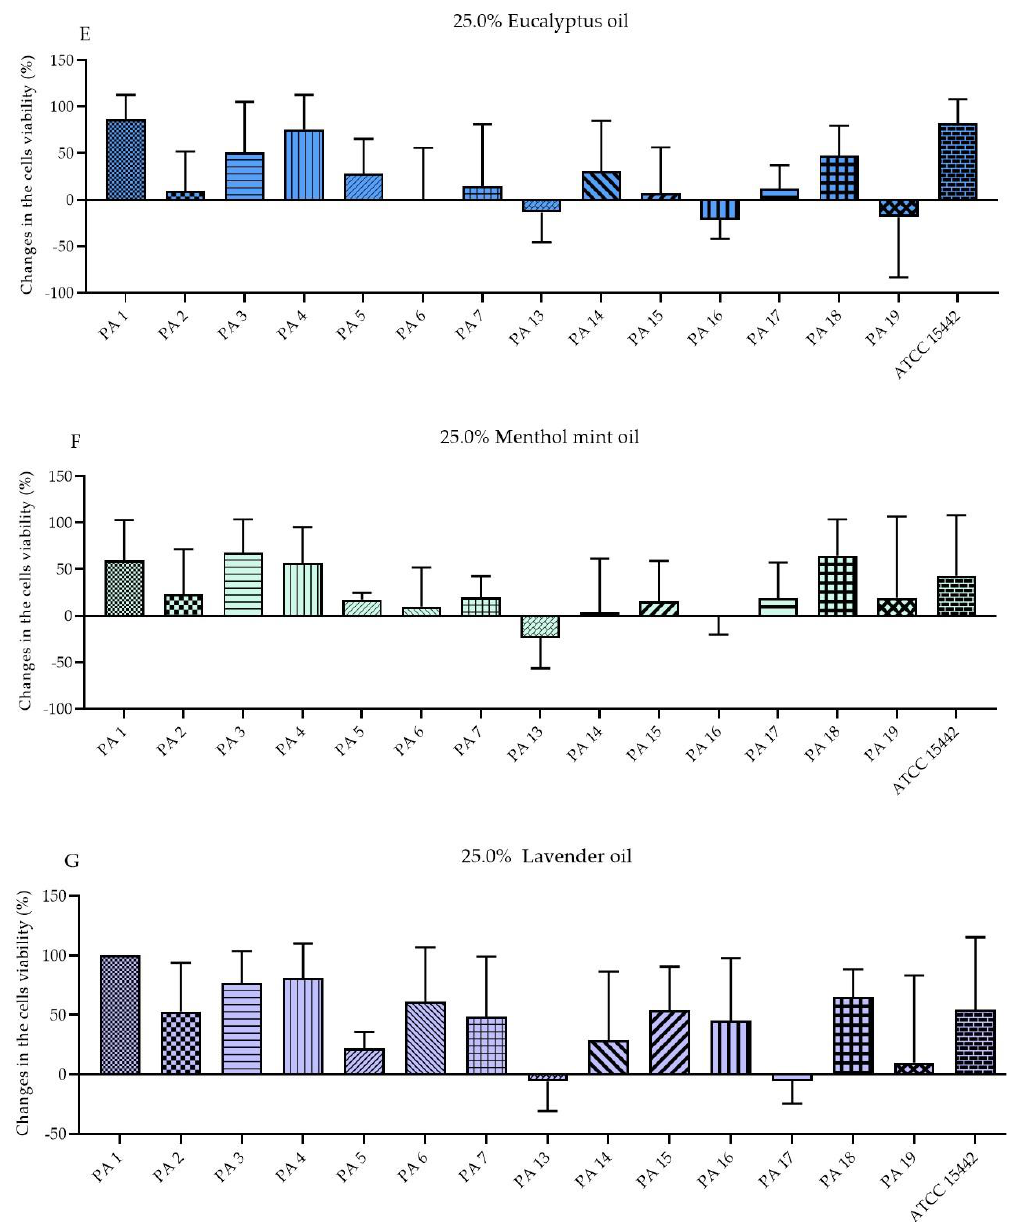
Figure 2. Changes in the biofilm-forming cells viability (%) of P. aeruginosa clinical (PA 1 – 7, PA 13 – 19) and the reference (ATCC 15442) strains after treatment with emulsified essential oils in their liquid forms in the concentration of 25.0% ( v / v ). Results of microdilution methodology with ( A , B ) TTC and ( C – G ) resazurin staining. Standard deviations are marked. The negative values indicate an increase in biofilm-forming cells viability after their treatment with EOs in comparison to the growth control (untreated